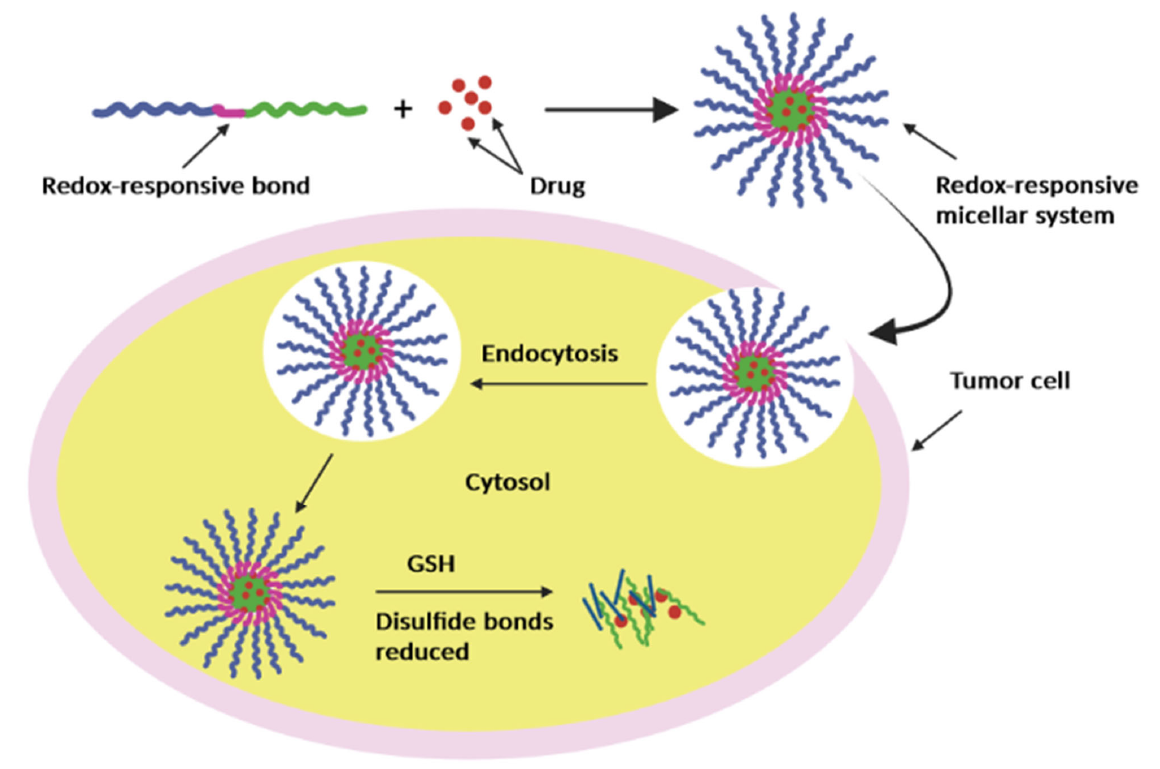
Figure 8. Redox ‐ responsive micelles’ method of action is depicted schematically. The micellar system enters the cancer cell by endocytosis and it actively releases the biologically active chemical into the cytosol as a result of GSH ‐ triggered disintegration.